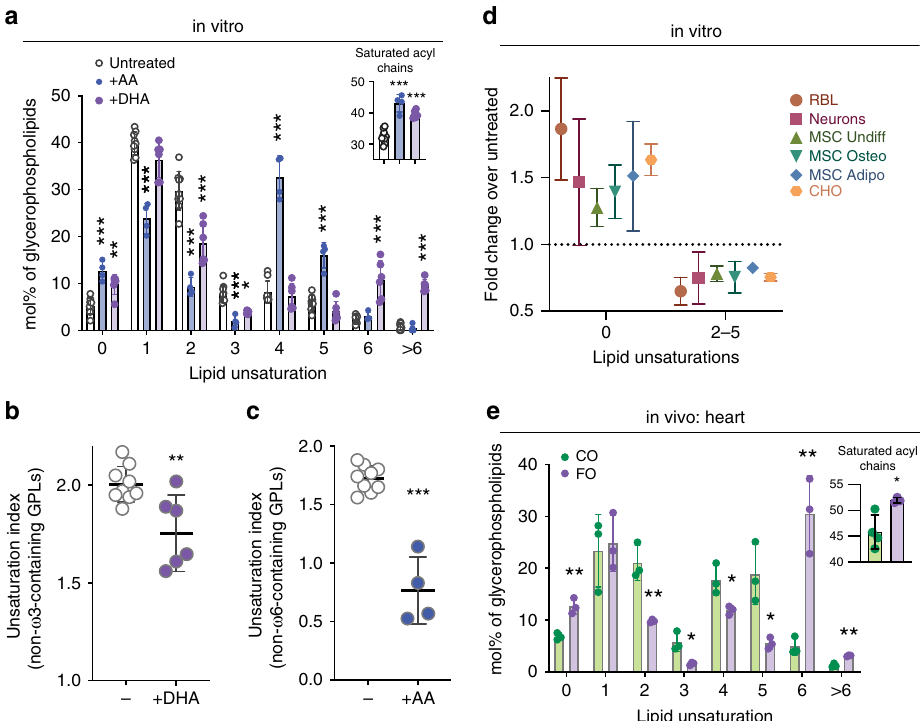
Fig. 2 Lipidome remodeling induced by PUFA incorporation. a Lipidome-wide remodeling of lipid unsaturation induced by DHA or AA supplementation. Both PUFAs induce signi fi cantly increased saturated lipids and decrease lipids containing di- and tri-unsaturated lipids. Inset shows the mol% of fully saturated acyl chains in GPLs. b , c The unsaturation index (concentration-weighted average lipid unsaturation) of lipids not containing the supplemented FAs and their derivatives is signi fi cantly reduced upon PUFA supplementation. For accurate estimates of lipidomic remodeling, the supplemented FAs and their derivatives are removed from the analysis, as the rather extreme over-abundance of those species upon supplementation suppresses the visualization of compensatory effects (e.g. for DHA supplementation, lipids containing 22:6, 20:5, or 24:6 are removed and then the unsaturation index of the “ remaining ” lipids is calculated). d DHA-mediated lipidomic remodeling, indicated by increased saturated lipids and decreased polyunsaturated lipids (2 – 5 unsaturations), is consistent across multiple cell types, including isolated rat hippocampal neurons, cultured human MSCs, and MSCs differentiated into adipogenic or osteogenic lineages. e Lipid unsaturation pro fi le in membrane lipids isolated from murine heart tissue after feeding with CO versus FO. Incorporation of ω -3 PUFAs into membrane lipids (see Fig. 1d) is associated with lipidomic remodeling, namely higher levels of saturated lipids. Inset shows the mol% of fully saturated acyl chains in GPLs. All data are average ±SD for n ≥ 3 biological replicates. ( a ) and ( e ) are two-way ANOVA with Sidak ’ s multiple comparison test. ( b , c ) and insets are student ’ s t test compared to untreated. * p < 0.05, ** p < 0.01, *** p < 0.001. Source data are provided as a Source Data fi